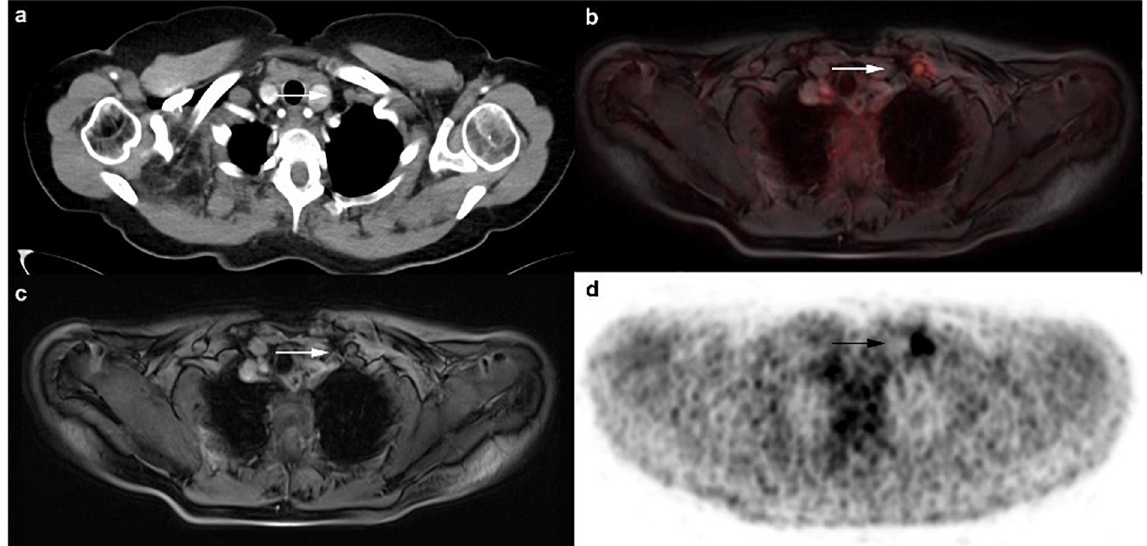
Fig 4. A 72-year old woman with diagnosis of primary breast cancer and lymph node metastases. The reading radiologist did not detect the morphologically inconspicuous left clavicular lymph node in CT scan ( a ). In 18 F-FDG PET/MRI a clear FDG uptake is visible ( b-d ). Histopathology confirmed malignancy.